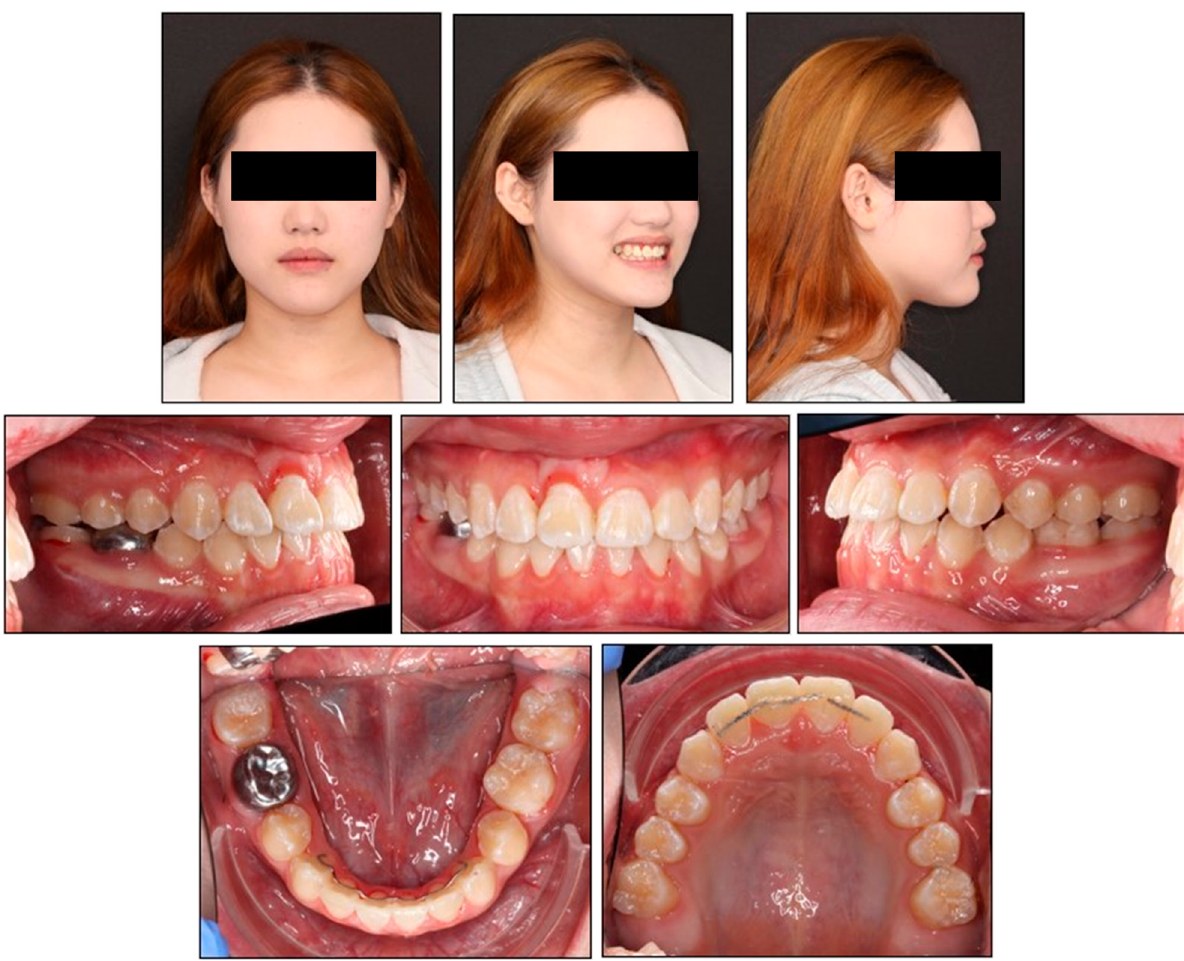
Figure 9. Debond extraoral and intraoral